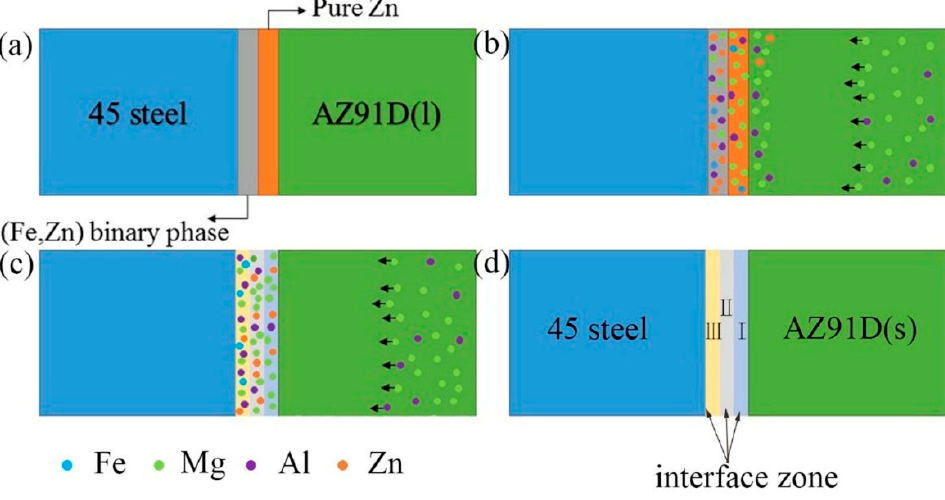
Figure 11. The schematic of microstructure evolution in the galvanized-steel / AZ91D interface. ( a ) filling process of liquid metals; ( b ) diffusion process and chemical reactions; ( c ) metallurgical reaction among the Al, Fe, Mg, Zn elements; and ( d ) solidification.